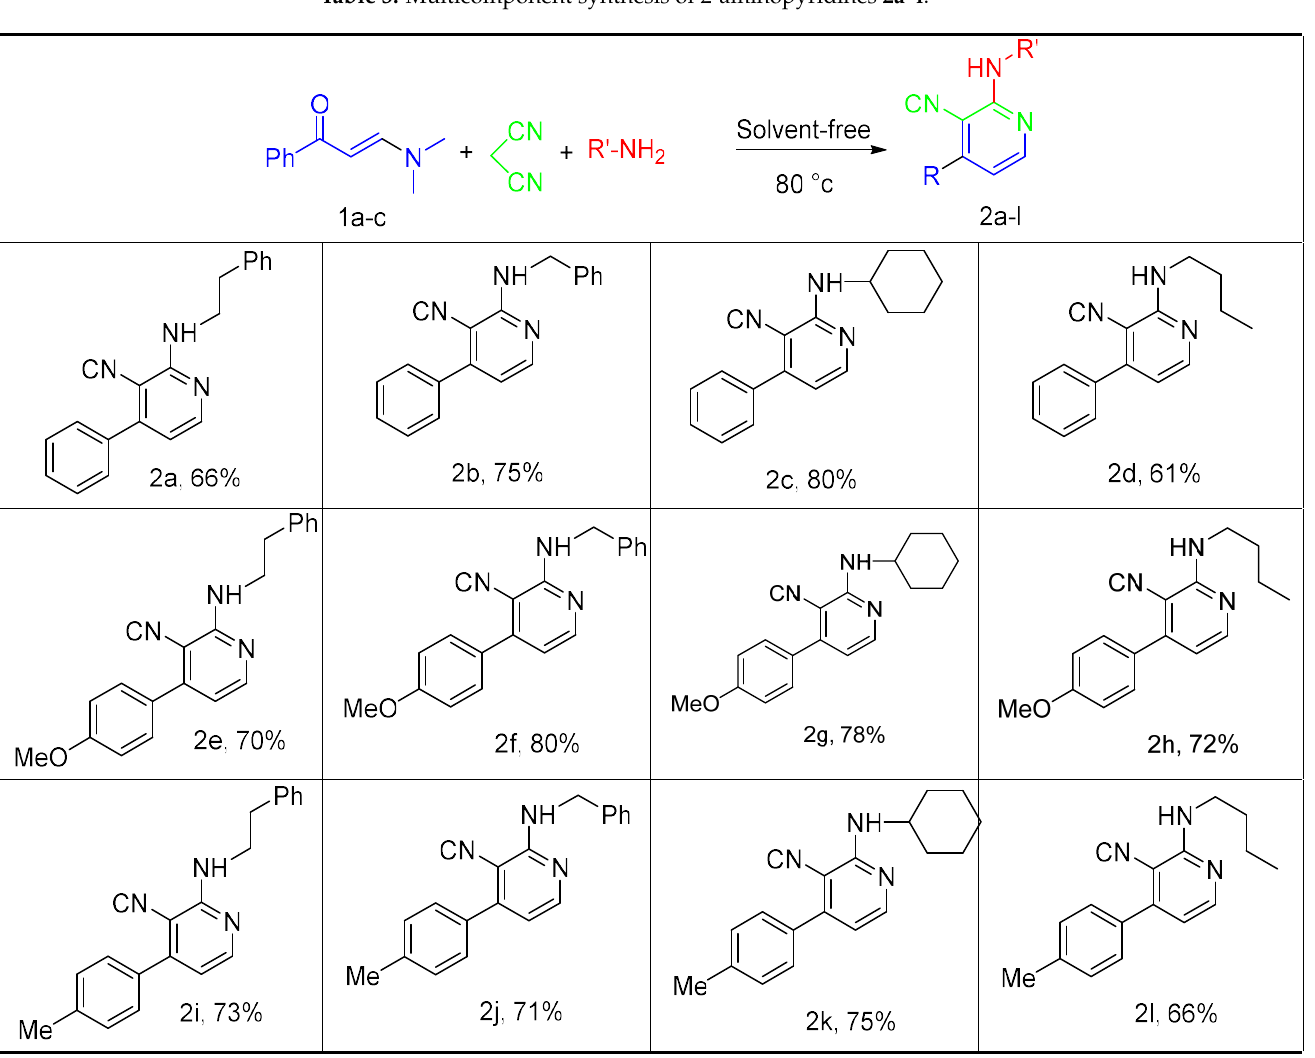
Table 3. Multicomponent synthesis of 2-aminopyridines 2a – l .